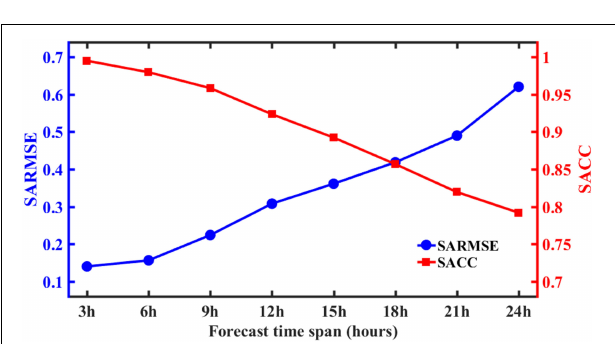
FIGURE 4 | Variations in the SARMSE (blue) and SACC (red) of each training result with forecast time span.